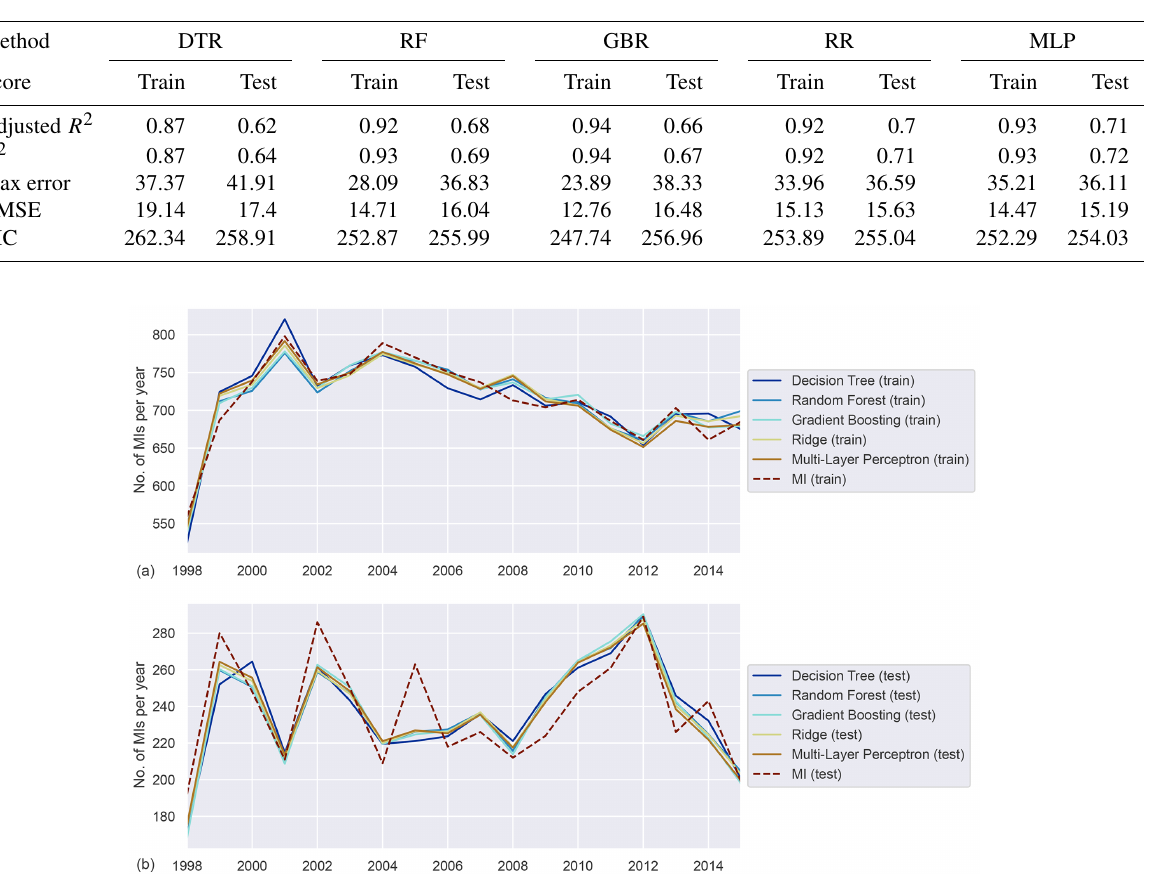
Table 5. Training and test scores on annual basis for the general population.